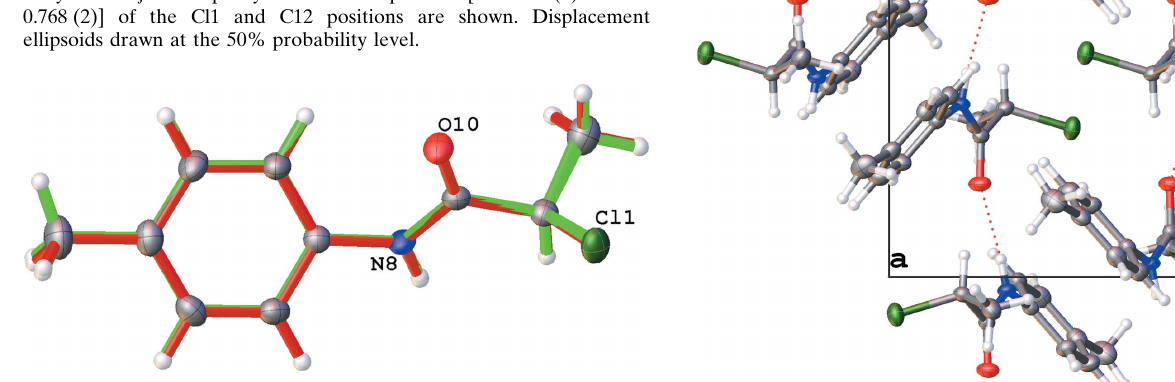
Figure 2 Overlay image of both molecules of 2-chloro- N -( p -tolyl)propanamide ( 1a is shown in red and 1b in green) with an r.m.s. fit of 0.040 A˚ (no inversion). Displacement ellipsoids shown at the 50% probability level. Selected atom numbering only for clarity.